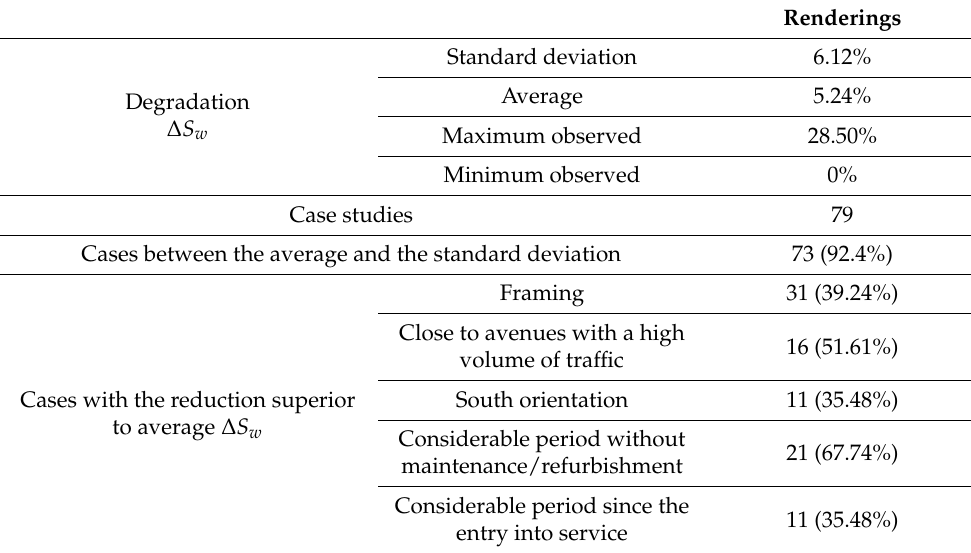
Table 3. Descriptive analysis of the impact of partial repair on the severity of degradation of